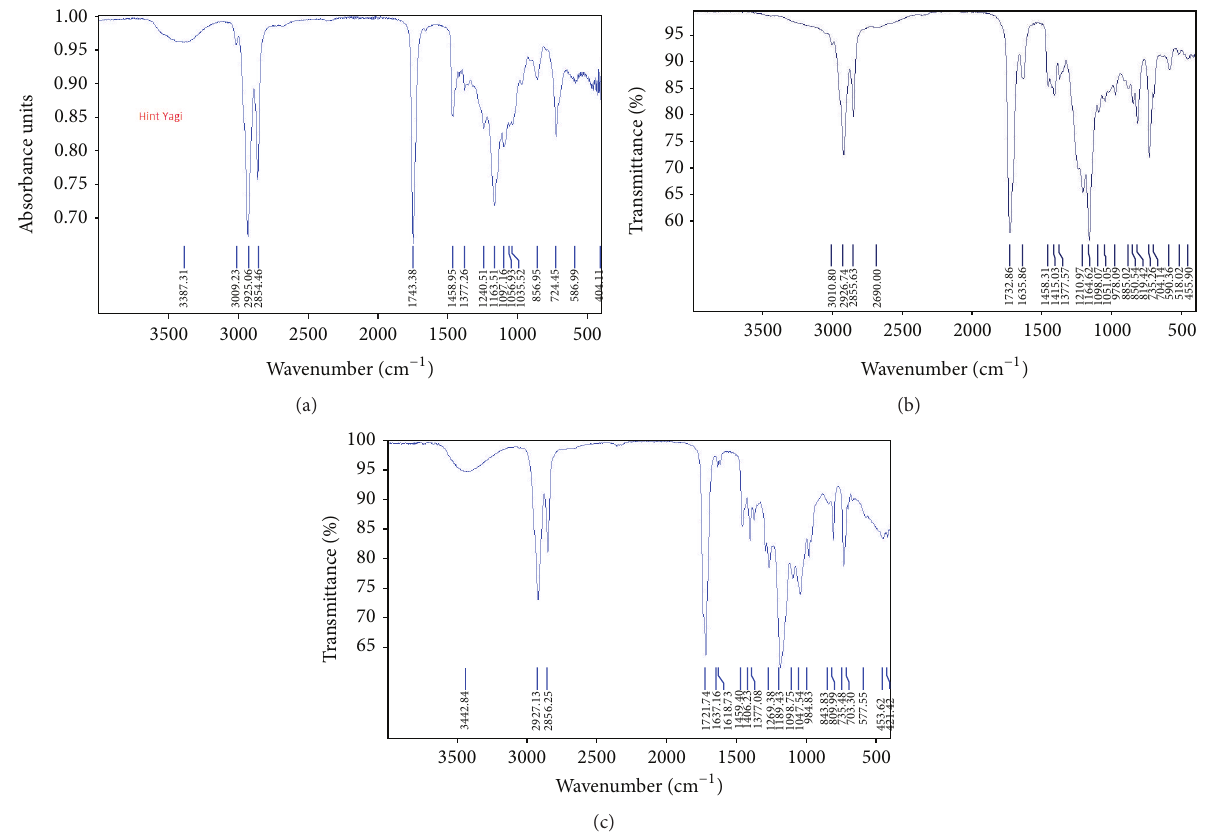
Figure 2: IR spectrum of (a) castor oil, (b) MACO, and (c)